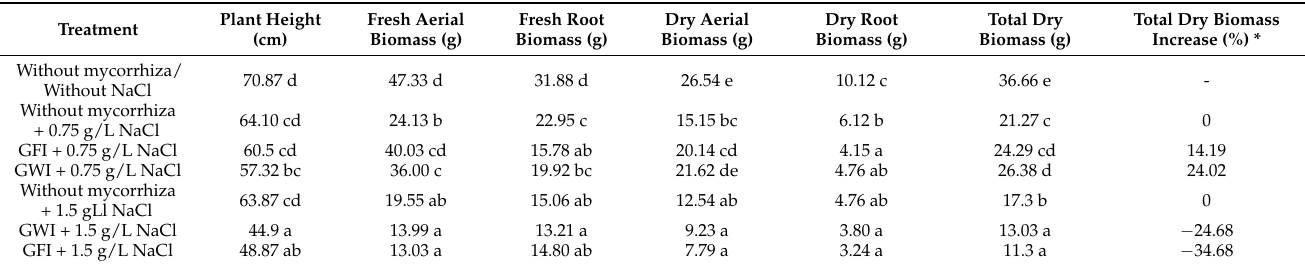
Table 5. Effect of inoculation with Glomeromycota fungi (GFI and GWI) on growth parameters in seedlings of Persea americana var. Zutano under salinity stress conditions.